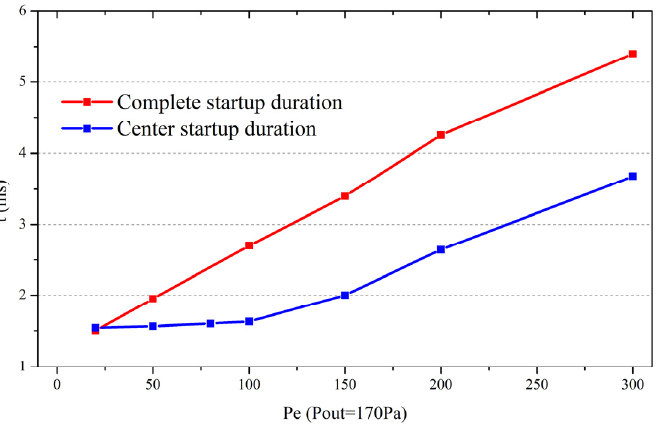
Figure 12. Center startup time and complete startup time.